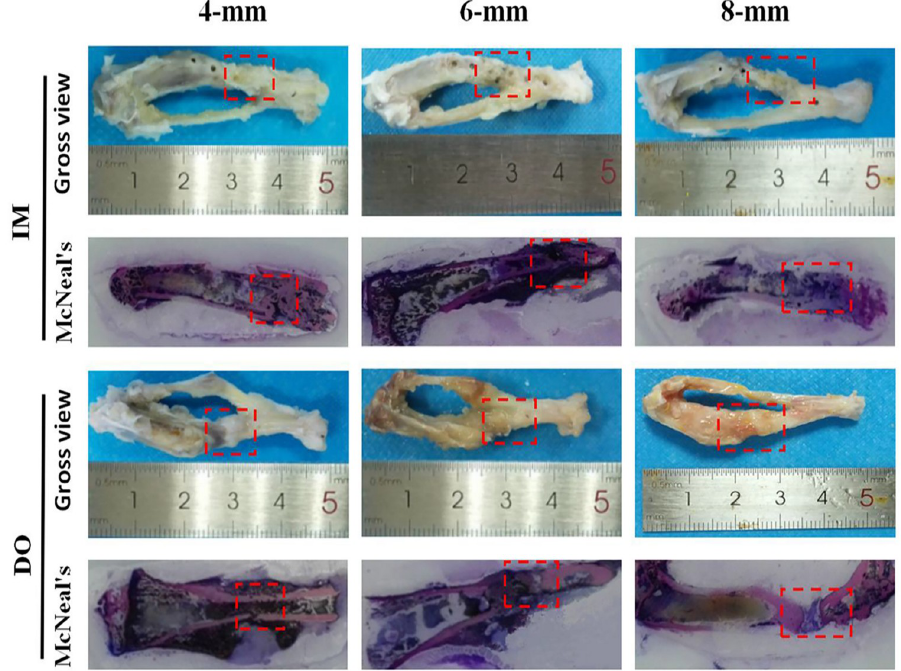
Fig 4. Overview and McNeal’s staining of representative samples harvested from 4-, 6- and 8-mm groups at 14 weeks after surgery. Undecalcified section were stained with McNeal’s. Mineralized bone tissue was stained pink and unmineralized tissue was light blue. Red dashed lines outline the defect